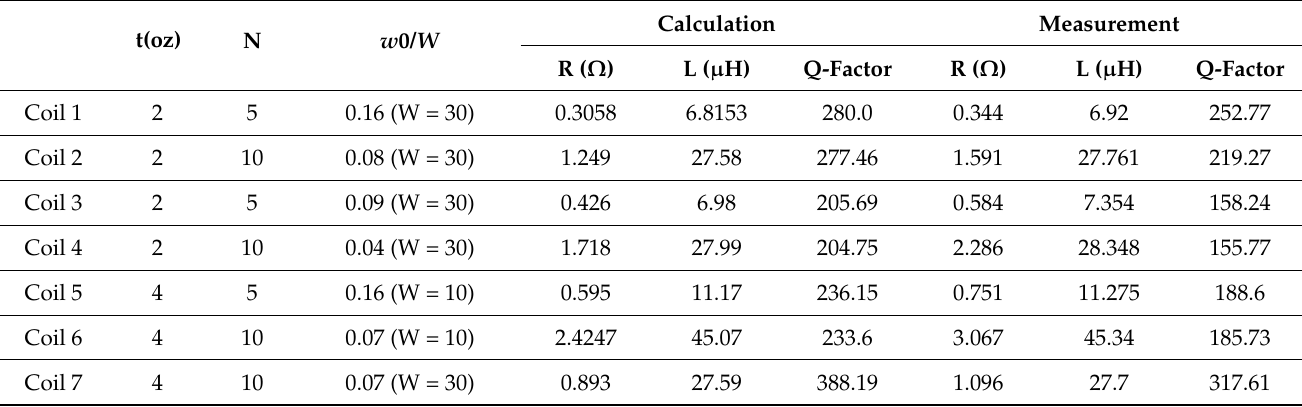
Table 1. Specifications of the fabricated coils, and comparison of the Q-factor at 2 MHz and ohmic losses of the coils between the measurement and calculation.